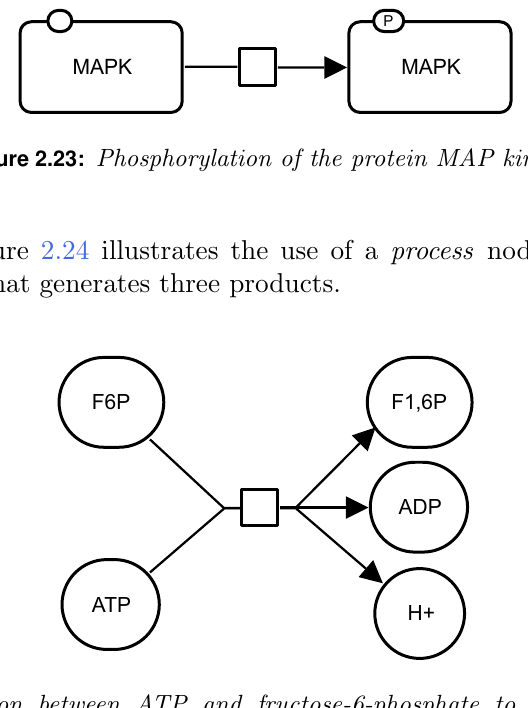
Figure 2.24: Reaction between ATP and fructose-6-phosphate to produce fructose-1,6- biphosphate, ADP and a proton.